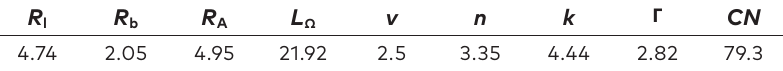
Table 1. Computed parameters to estimate GIUH ordinates R l R b R